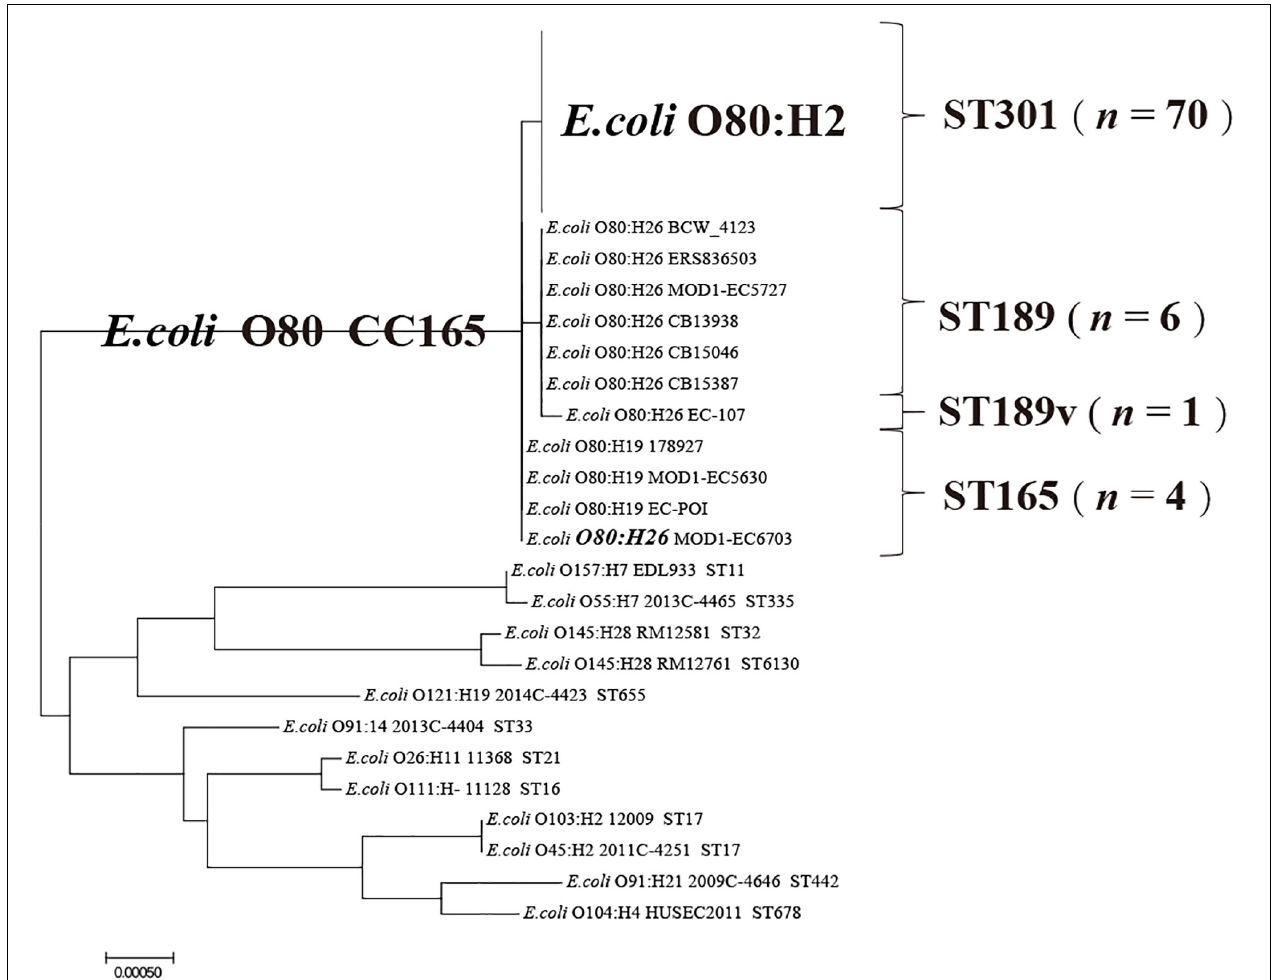
FIGURE 1 | Phylogenetic analysis of STEC O80 strains based on MLST as well as 12 reference STEC strains. The sequences of seven house-keeping genes ( adk, icd, fumC, purA, gyrB, icd, and recA ) from STEC O80 strains and 12 reference STEC strains are concentrated to construct a neighbor-joining